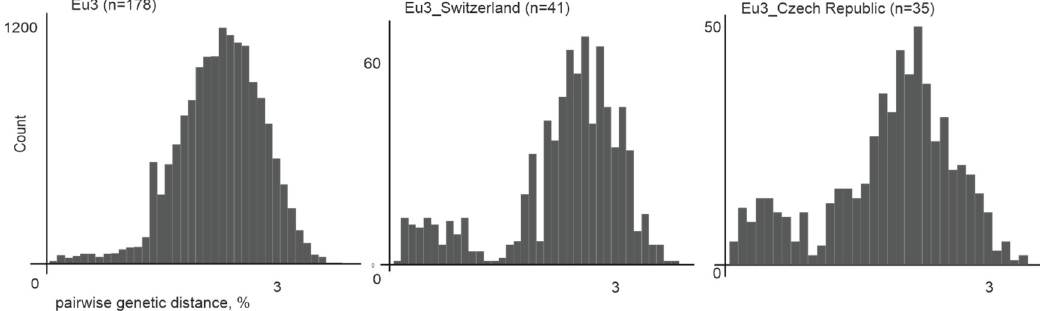
Figure 8. Pairwise genetic distances for all Eu3 representatives ( n = 178), Eu3 from Switzerland ( n = 41), and Eu3 from the Czech Republic ( n = 35).